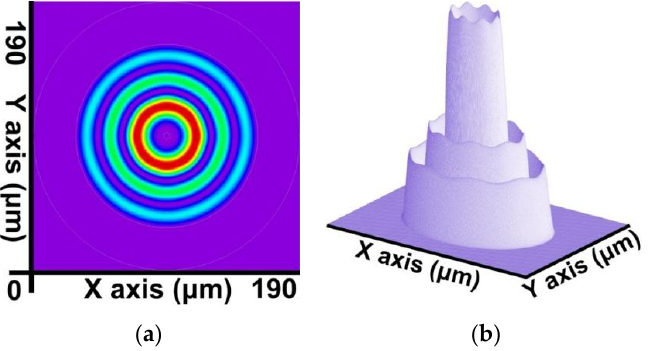
Figure 12. The 2D and 3D power distribution patterns of the cladding modes (v = 39) with an effective refractive index of 41.42930192 39 eff n . ( a ) The 2D power distribution; ( b ) the 3D power distribution.